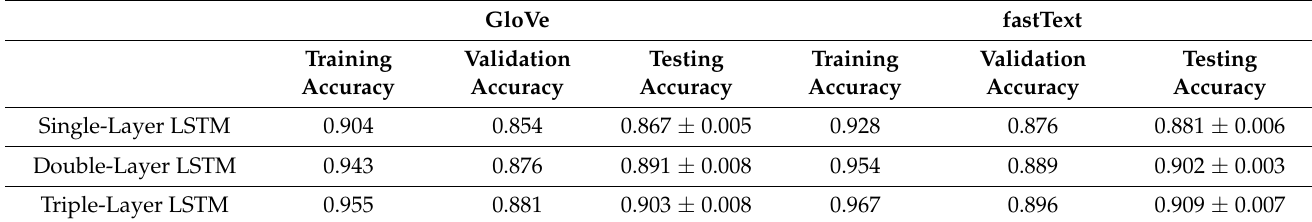
Table 7. Results of training, validation, and testing accuracy on 5 fold cross validation.